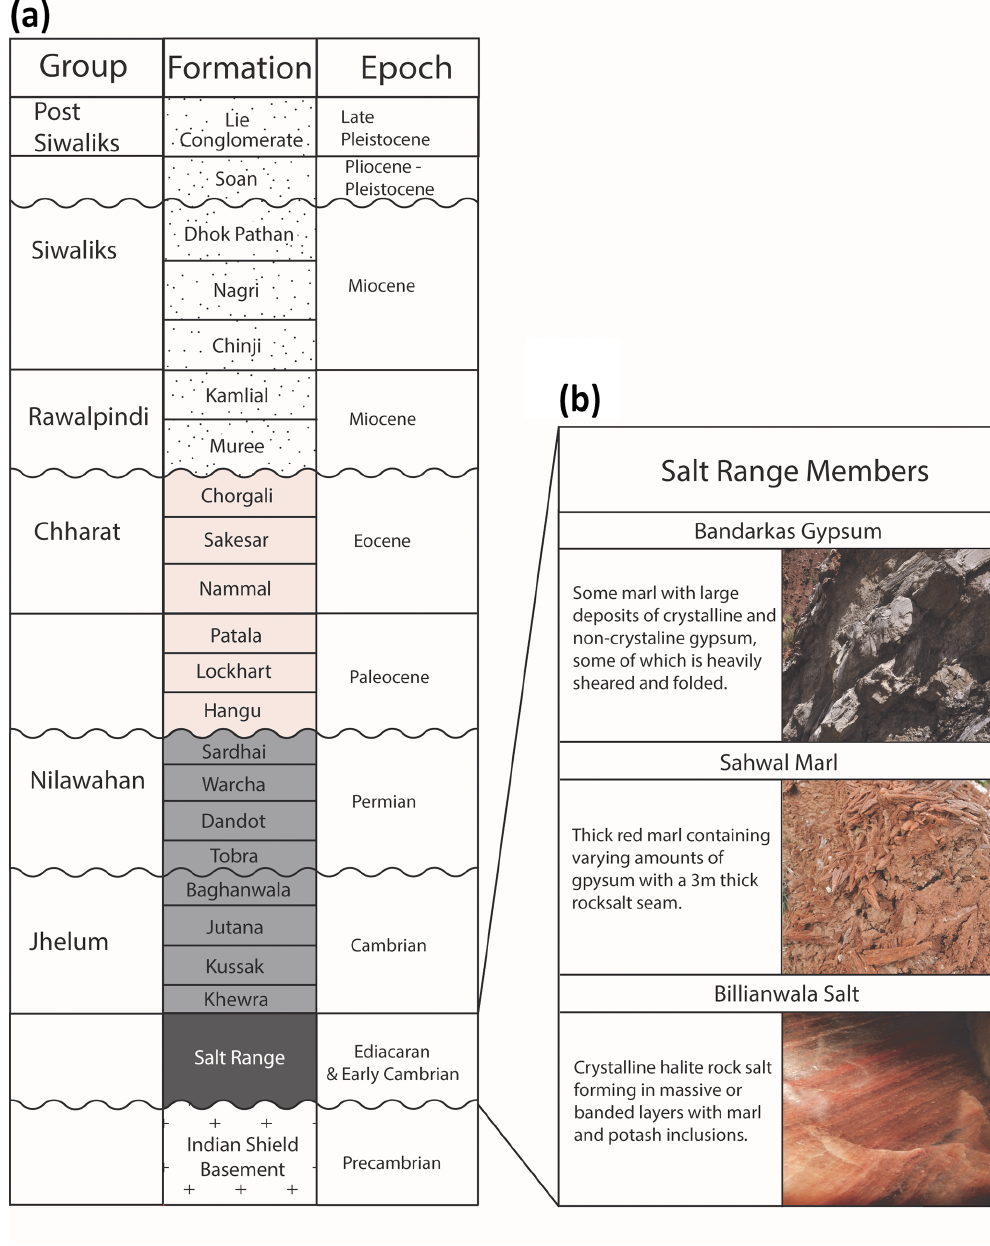
is 10 min, which includes 8 min of static temperature with first 2 min ramping to the desired temperature. Mass spec- trometer analysis occurs at the end of each step where the temperature drops by 150 ◦ C. For both gas extraction ap- proaches, the gas was purified in a stainless-steel extraction line using one GP50 and two SAES AP10 getters. Argon isotopes were measured in static mode using a MAP 215- 50 mass spectrometer (resolution of ∼ 450; sensitivity of 4 × 10 − 14 mol V − 1 ) with a Balzers SEV 217 electron mul-